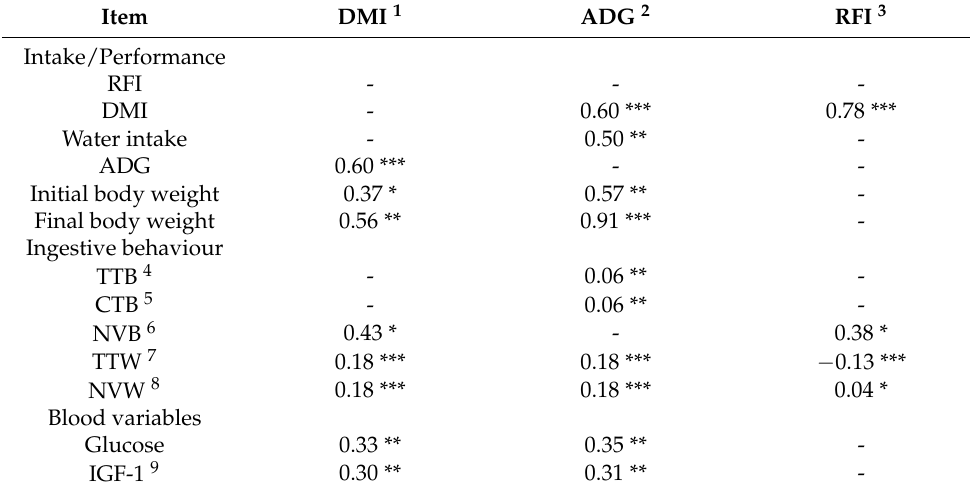
Table 4. Phenotypic correlation of dry matter intake (DMI), average daily gain (ADG), and RFI with the performance indexes and evaluated variables in dairy heifers phenotypically classified for RFI. Item DMI 1 ADG 2 RFI 3 Intake/Performance RFI